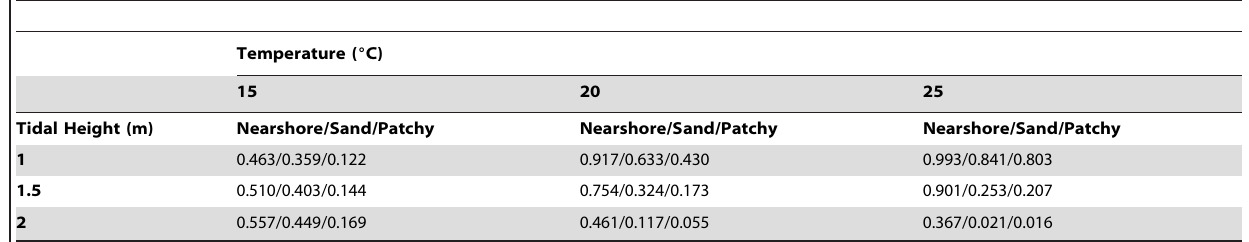
Table 1. Matrix of predicted probabilities of giant shovelnose ray ( Glaucostegus typus ) occurrence per microhabitat for selected temperatures and tidal heights.